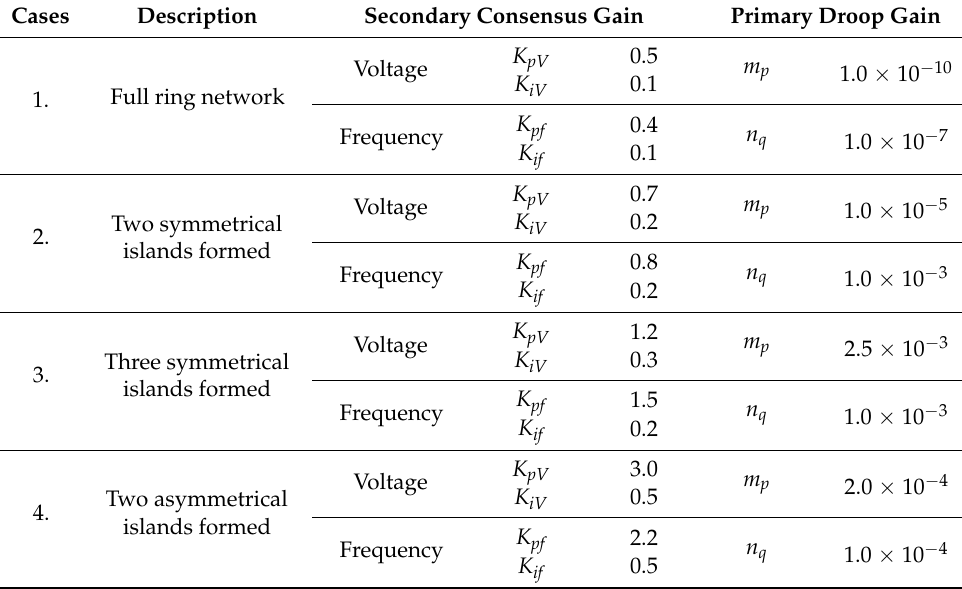
Table 3. Controller parameters for analyzed